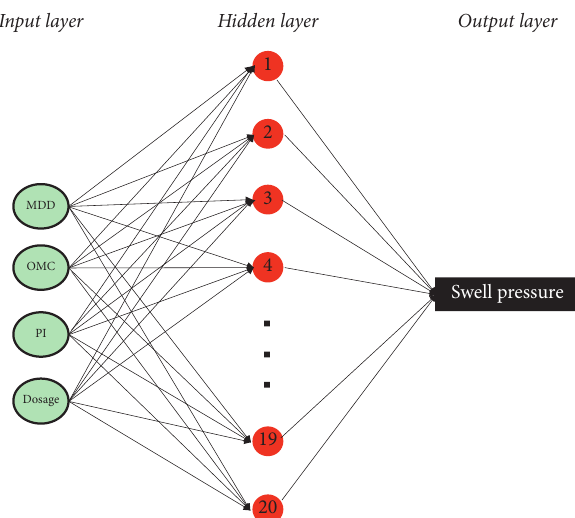
Figure 10: Artificial Neural Network (ANN) model